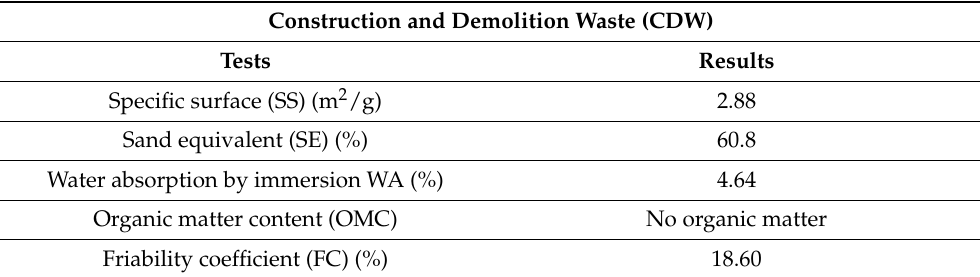
Table 4. Results of the technological quality tests of the CDW were investigated in this work. Construction and Demolition Waste